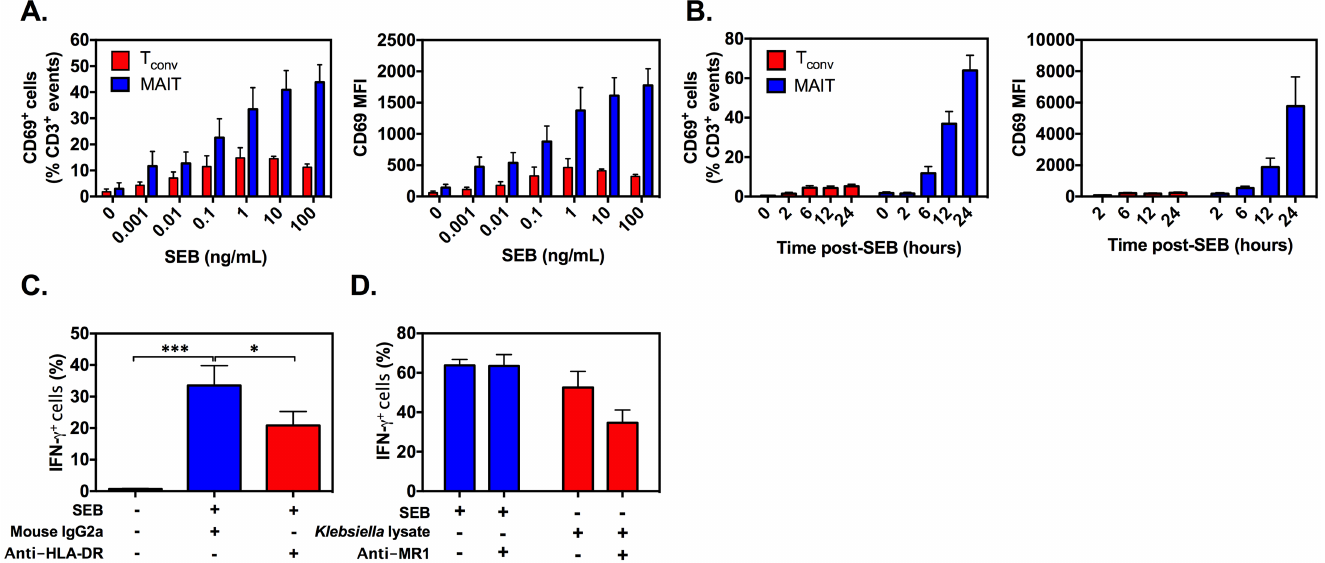
Fig 3. Rapid, exaggerated mucosa-associated invariant T (MAIT) cell responses to staphylococcal enterotoxin B (SEB) require the presenceof HLA class II but not MHC-related protein 1 (MR1). Human peripheral blood mononuclear cells (PBMCs) were stimulatedfor 12 h with indicateddoses of SEB ( A ) or for indicateddurationswith 100 ng/mL of SEB ( B ) before the frequency of CD69 + events and the mean fluorescence intensity (MFI) of CD69 were determinedamongMAIT and conventional T (T conv ) cells. Data were pooledfrom at least 3 independentexperiments, and mean ± SEM values are shown ( n = 5 for A and n = 8 for B). PBMCs ( n = 9 in C; n = 3 in D) were incubatedfor 24 h with SEB ( C-D ) or Klebsiella lysate ( D ) in the presenceof an HLA-DR-blockingmonoclonal antibody (mAb) or an isotype control ( C ) or an anti-MR1 mAb ( D ). The percentage of interferon(IFN)- γ + events amongMAIT cells is reported, and error bars represent SEM. The underlying data for this figure can be found in S1 Data, and our gating strategies are providedin S2 Data.